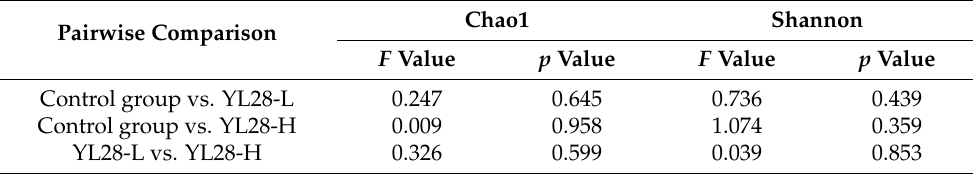
Table 2. Significance analysis of Chao1 and Shannon between treatment